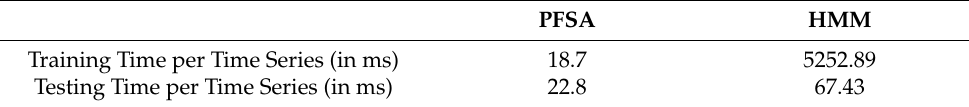
Table 5. Training and testing times: PFSA and